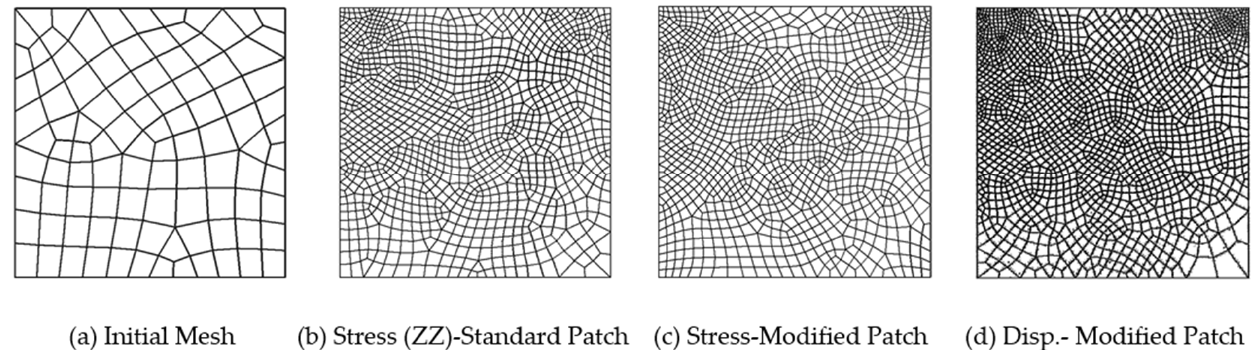
Figure 9. Adaptively modified mesh in benchmark plate problem using stress/displacement recovery and patch configu- ration (quadrilateral elements initial mesh = 99.4% target error).